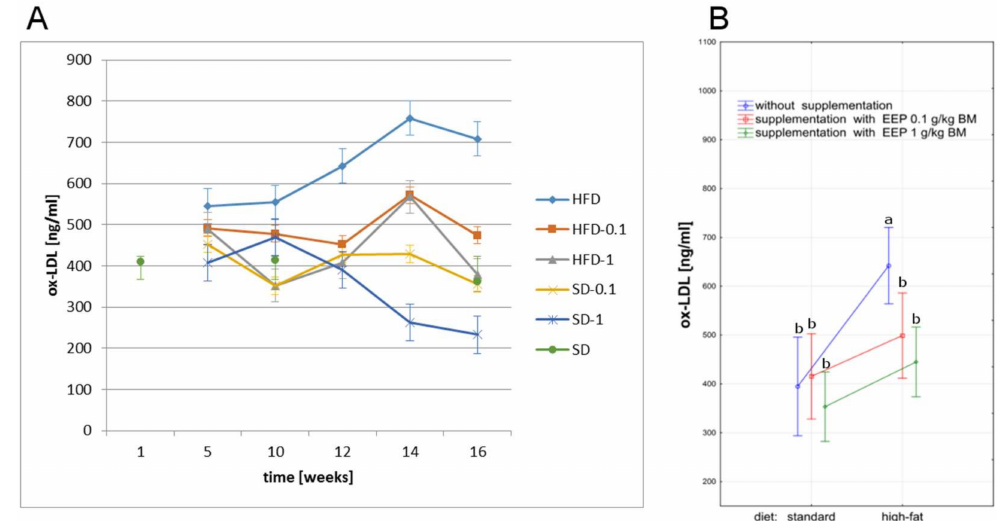
Figure 4. Oxidized low density lipoproteins level in C 57 BL 6 mice. ( A ) Ox-LDL level in